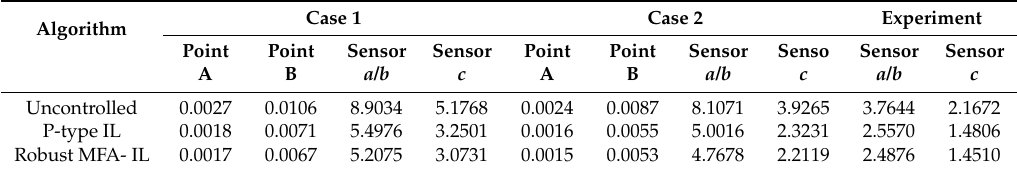
Figure 5. The time-domain responses of actuators/sensors: ( a ) Actuator a / b , ( b ) actuator c , ( c ) sensor a / b , ( d ) sensor c . Table 6. Root mean square (RMS) values of amplitude.